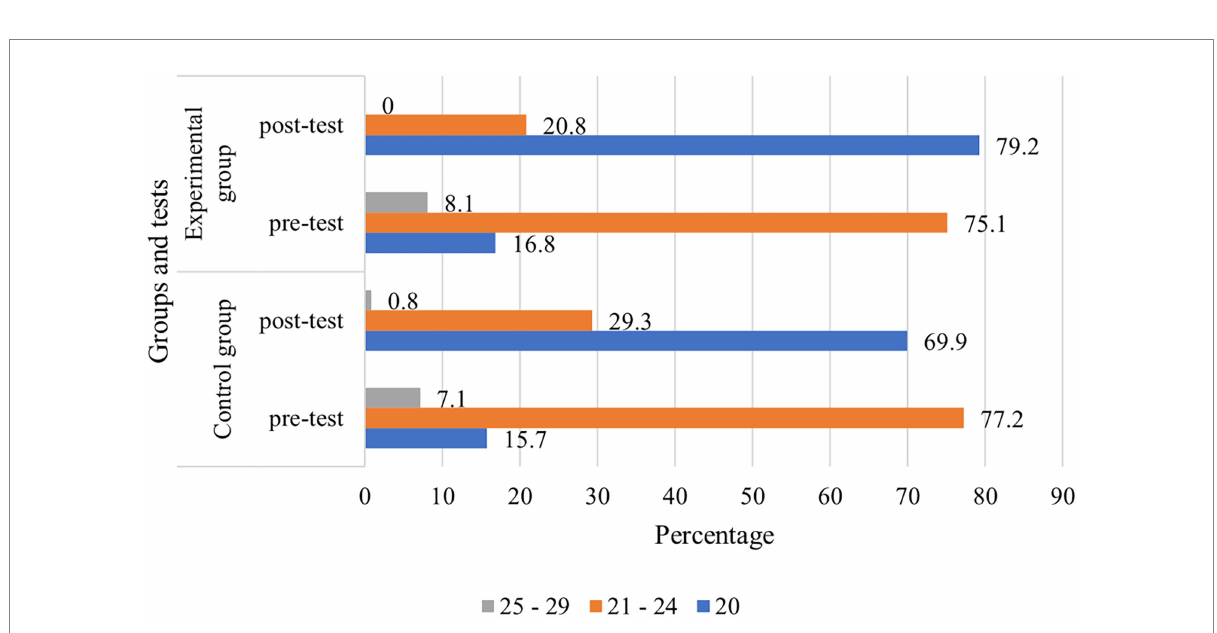
FIGURE 3 Pre- and post-testing results by